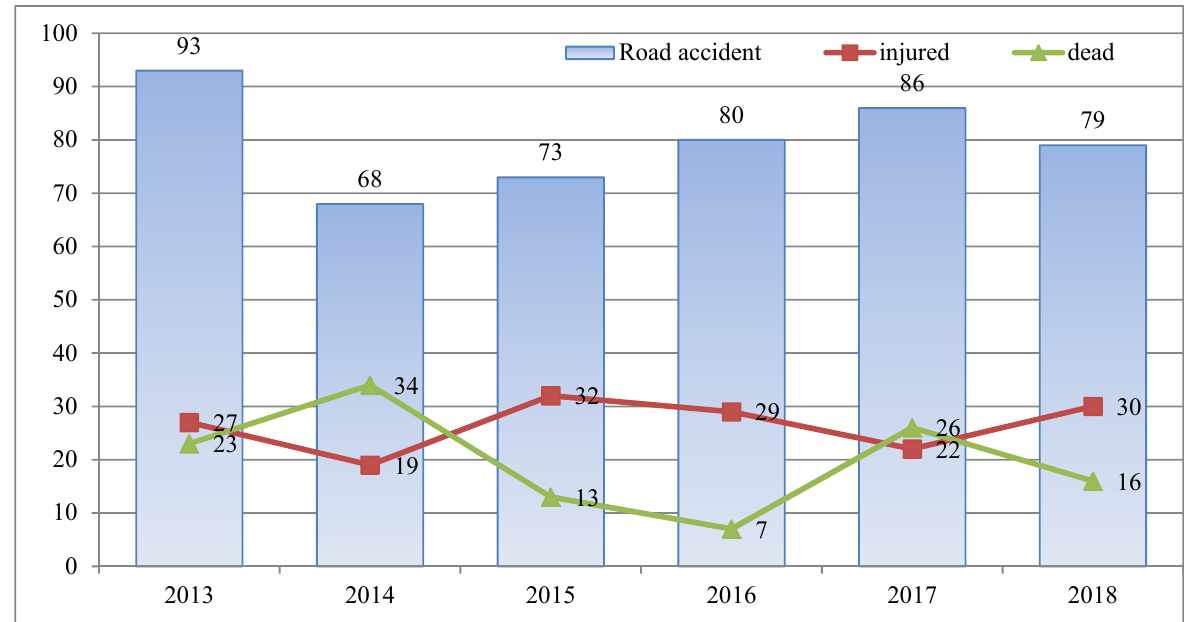
Fig. 1. Statistics on the railway accident in Ukraine